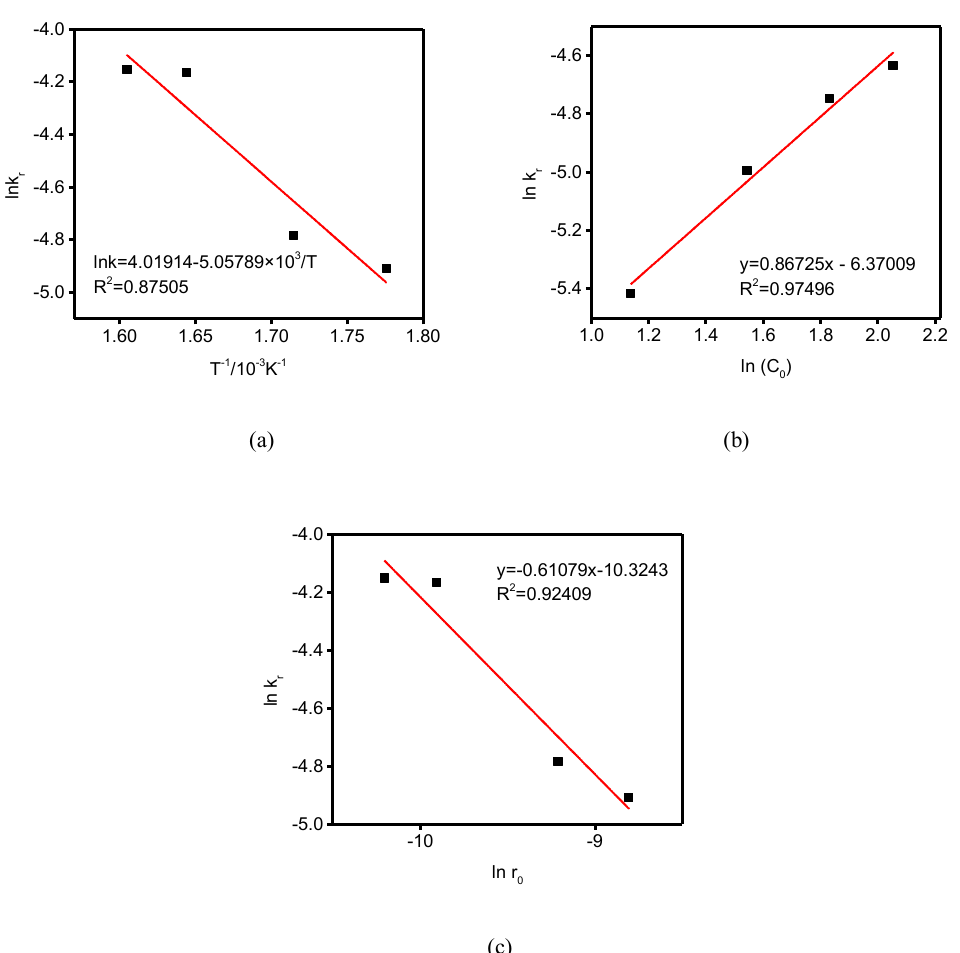
Figure 14. Relationships between ln k and 1/ T , ln( C 0 ), and ln r 0 : (a) Arrhenius plot of the calcination process at 290, 310, 335 and 350 °C; (b) relationship between ln k r and ln( C 0 ); and (c) relationship between ln k r and ln r 0 .